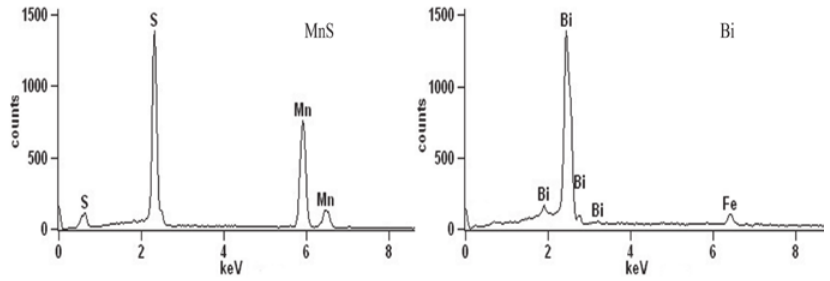
Fig. 3: EDS analysis results of MnS and Bi for Fig. 2